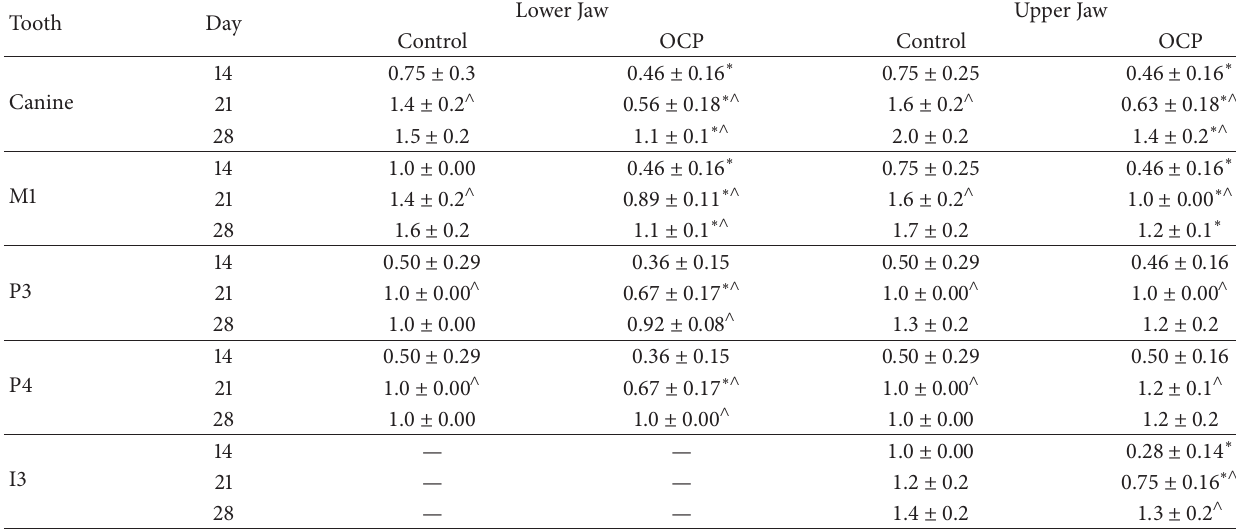
Table 3: Plaque index (coverage scores) on selected teeth in the lower (mandibular) and upper (maxillary) jaws of control and treatment dogs. Mandibular I3 was not part of the assessment.